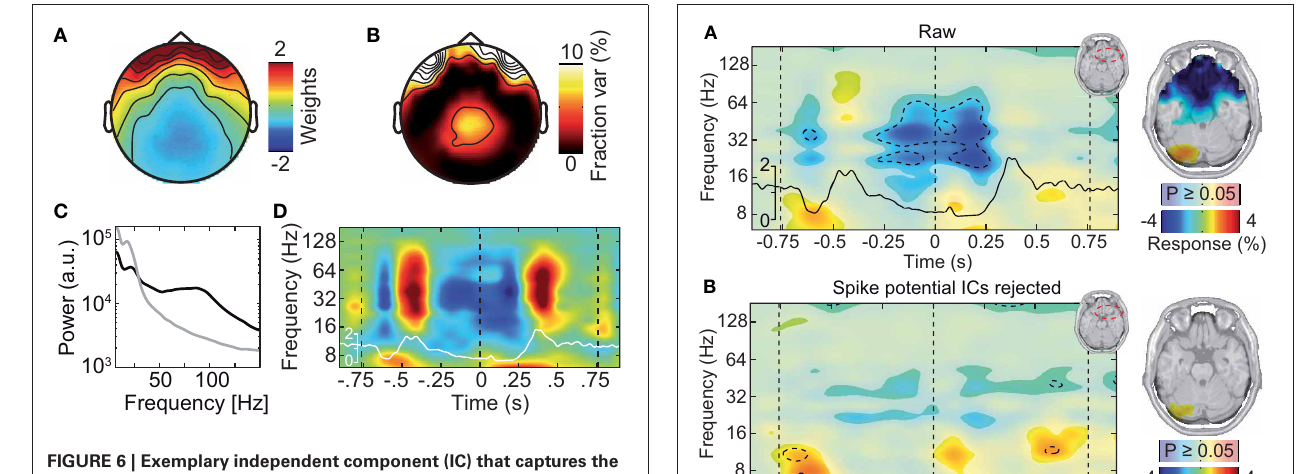
signal power for the data cleaned for muscle artifacts). To test